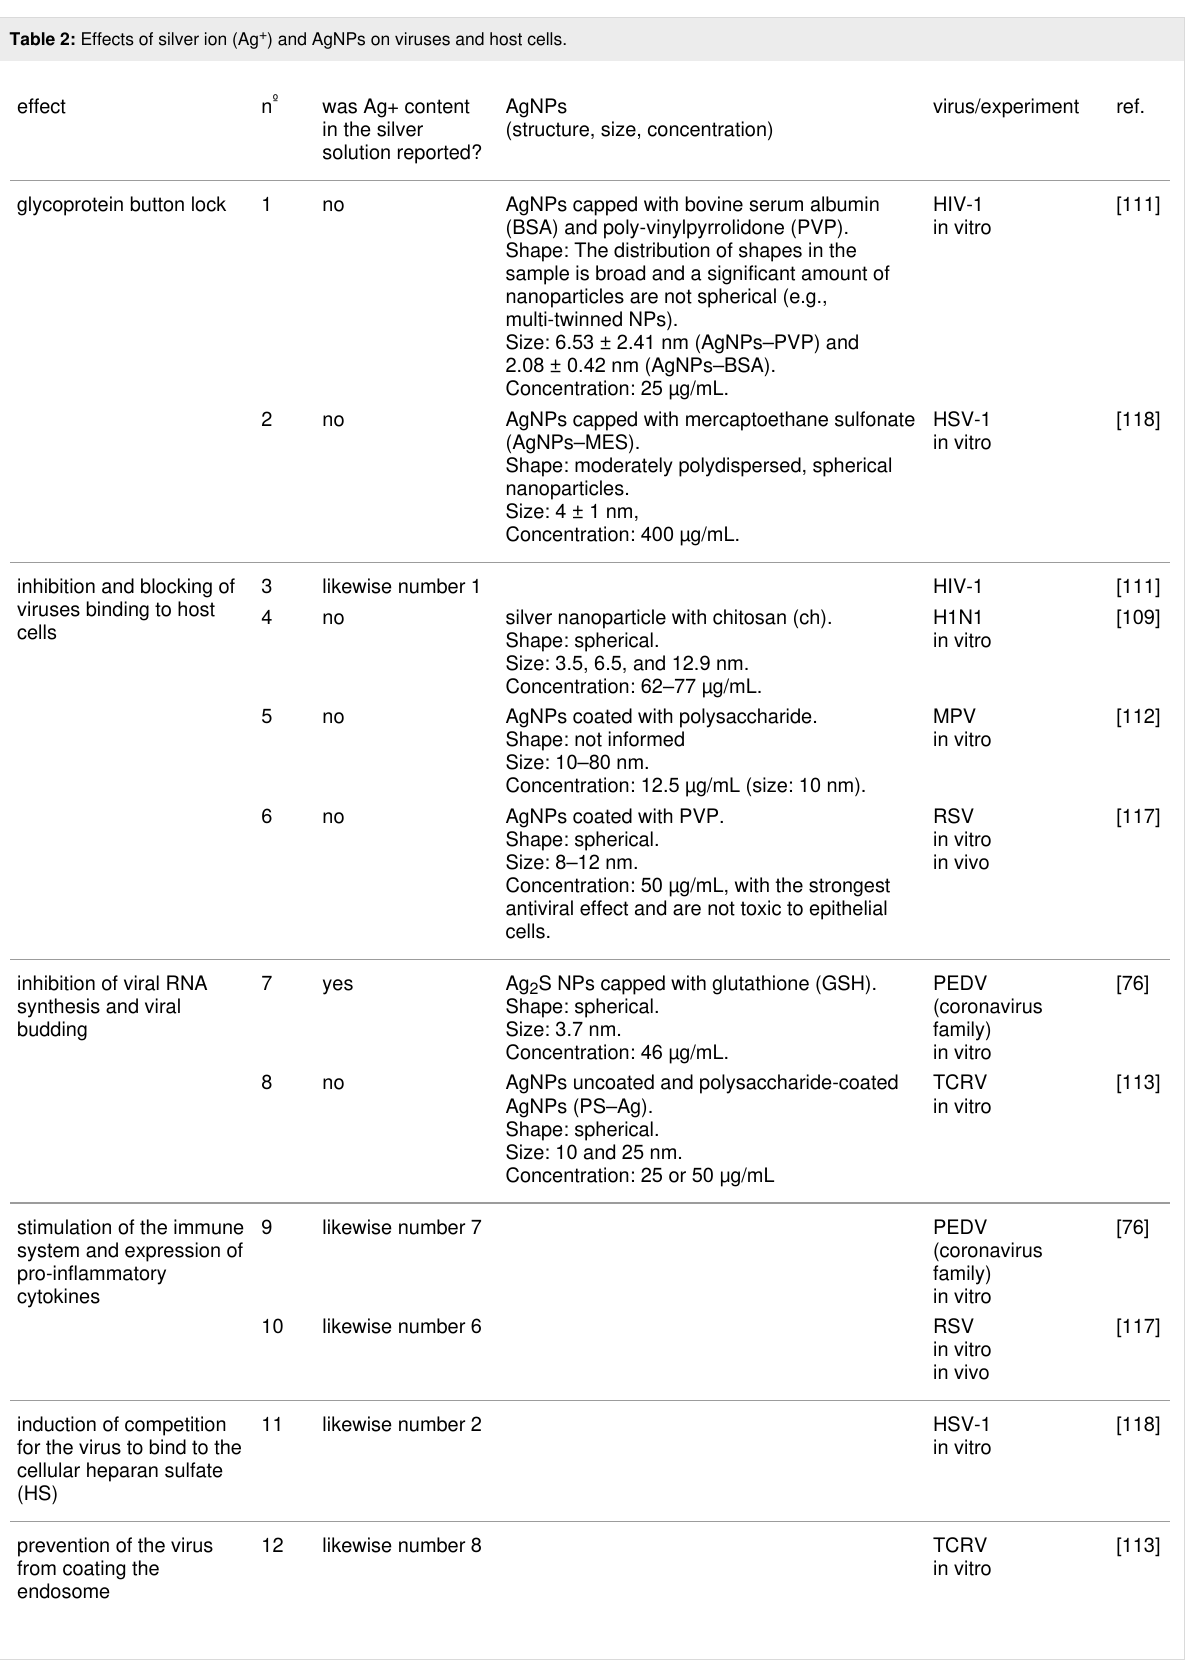
Table 2: Effects of silver ion (Ag + ) and AgNPs on viruses and host